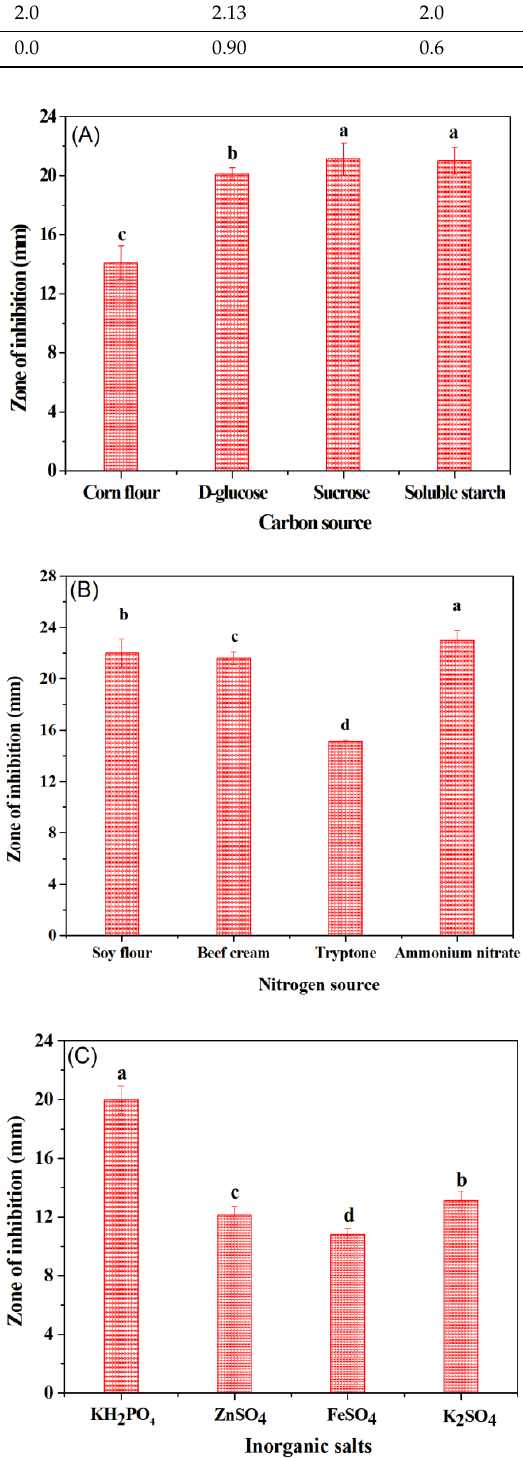
Figure 3. E ff ects of di ff erent ( A ) carbon sources ( B ) nitrogen sources and ( C ) inorganic salts on the Figure 3. Effects of different ( a ) carbon sources ( b ) nitrogen sources and ( c ) inorganic salts on the antibacterial potential of B. subtilis antibacterial potential of B. subtilis natto.